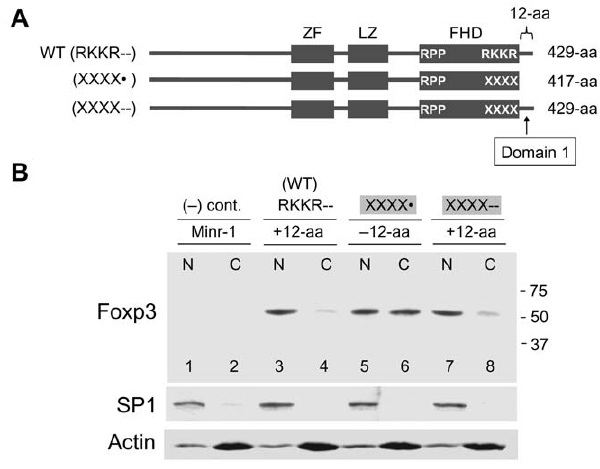
Figure 2. The C-terminal 12-aa residues (Domain 1) contribute to nuclear localization. A. Schematic diagram of WT Foxp3 (RKKR--), C-short mutant (XXXX N ) and full-length mutant (XXXX--). Domain 1 that corresponds to the C-terminal 12-aa tail and necessary for efficient translocation of Foxp3 is marked. B. Western blot showing increased nuclear translocation of Foxp3 following the addition of tail residues (lanes 5–8; 2 12-aa versus + 12-aa). CD4 + cells were harvested 24 hr after retroviral transduction. Lower panels, SP1 (nuclear) and Actin (cyto- plasmic) controls.